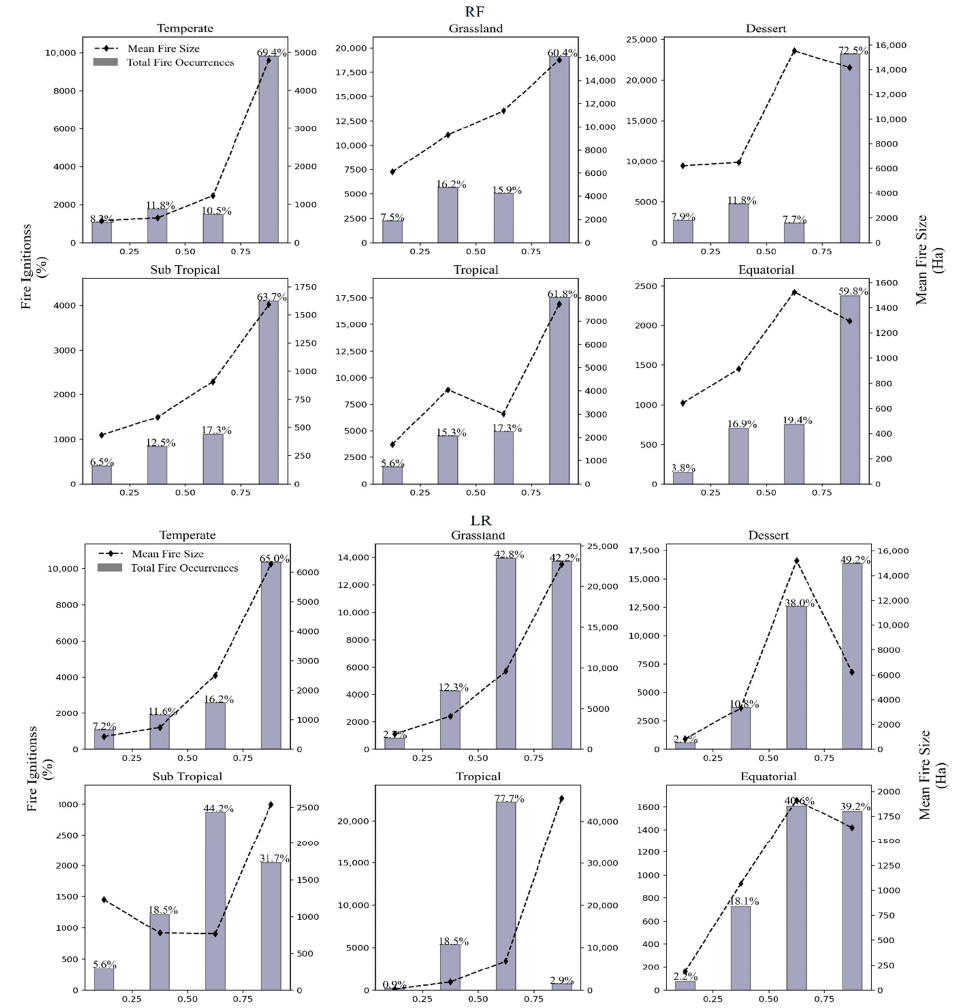
Figure 6. Evaluation of the RF and LR models developed with attribute-refined data (Outlier removed from Temperature and relative humidity predictors in class 0 (no-fire class)). The model predicted probabilities in four categories are shown with the total number of fire ignitions and mean fire sizes. The figures on top of each bar denotes the percentage of a number of fires in each probability category out of the overall total number of fires.